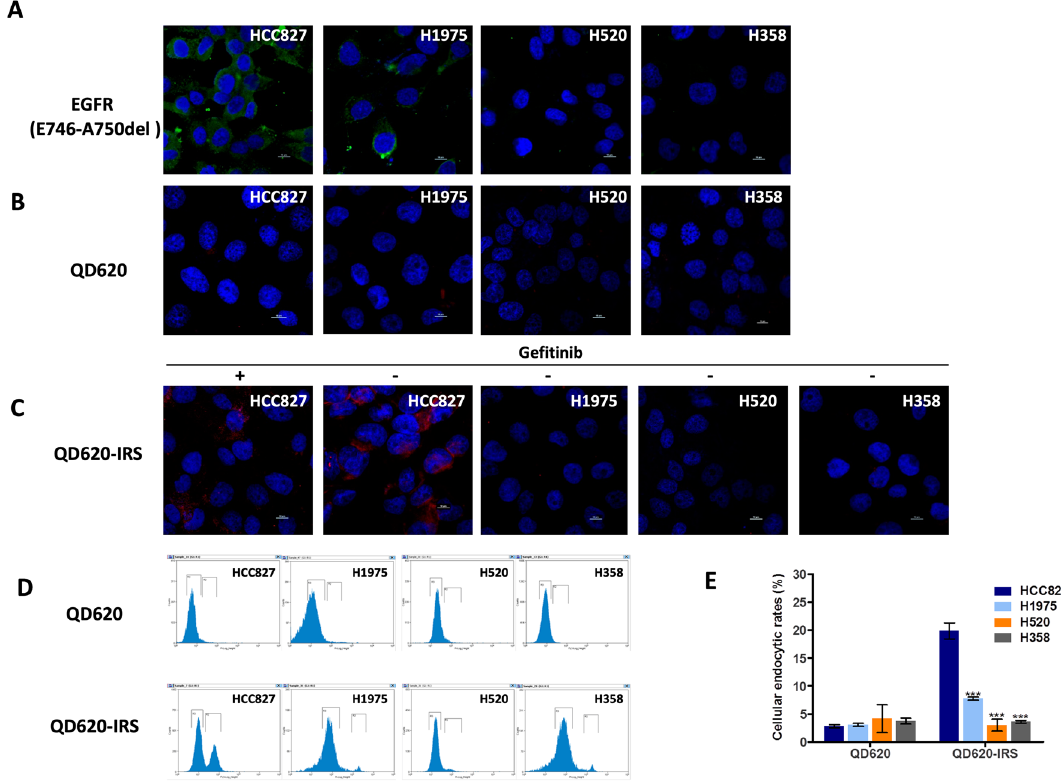
Figure 7. Quantitative analysis of QD620-IRS binding affinity by confocal imaging and flow cytometry. ( A ) Comparison of the expression levels of EGFR specific E749-A750del mutation in HCC827, H520, H1975 and H358 cell lines by immunofluorescence (Green color is from Alexa Fluor®488 secondary antibody, blue color from DAPI). ( B ) There is little uptake of QD620 in the four cell lines. ( C ) QD620-IRS uptake in HCC827 cells expressing EGFR 19 exon deleted mutation is considerably higher than in H1975, H520 and H358 cells. The binding of QD620-IRS in HCC827 cells was inhibited by application of gefitinib (100 μmol/L) (red circle is from QD620-IRS and blue color from DAPI). All scale bars 10 μm. ( D ) Flow cytometric analysis of endocytic rates in HCC827, H1975, H520 and H358 cells incubated with QD620-IRS or QD620 1 h. In ( E ), error bars indicate the mean ± S.D. of data from three separate experiments. *** P < 0.001 vs. HCC827